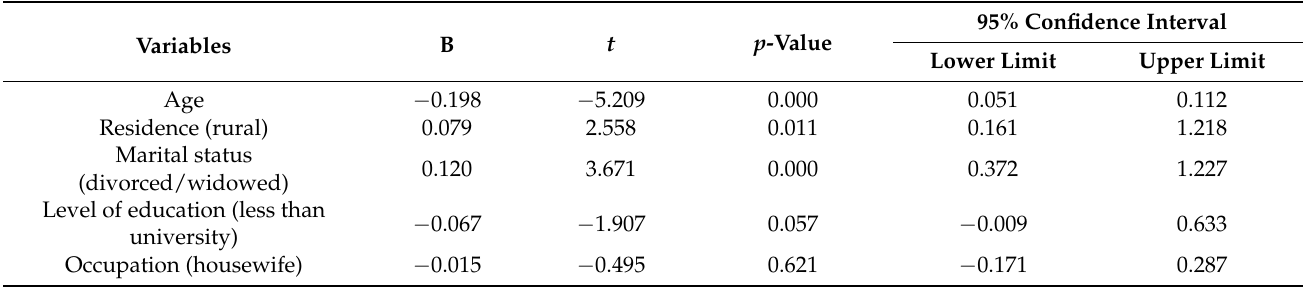
Table 4. Linear regression model showing the predictors of the somatic domain in MRS score among Saudi women attending different primary health